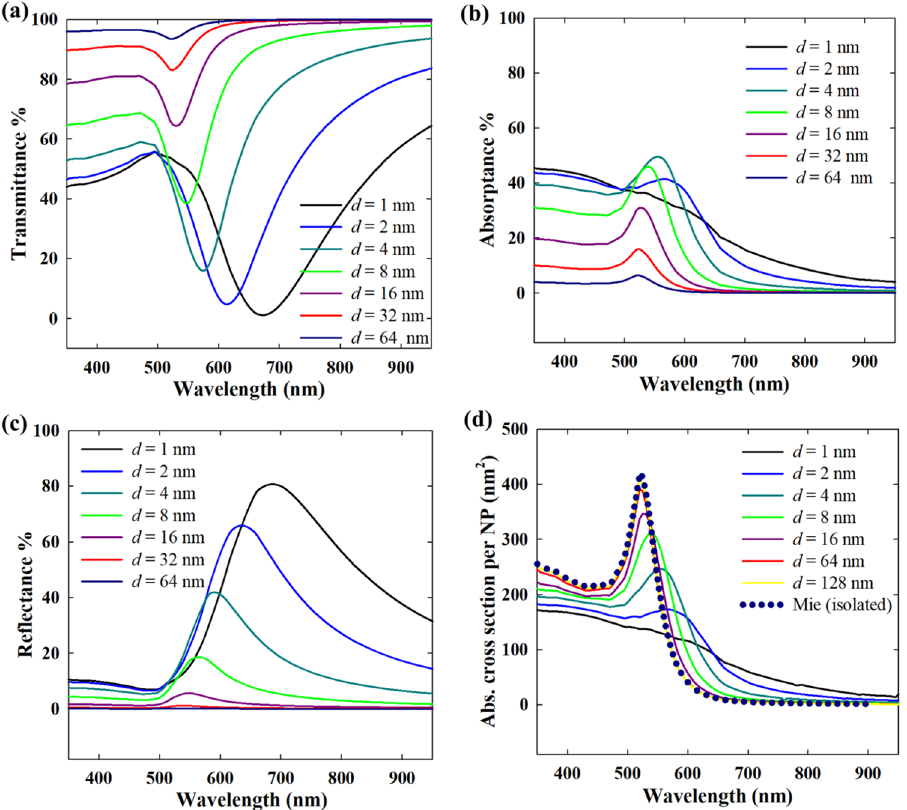
Figure 4. Effect of interparticle gap ( d ) in monolayer hexagonal close packed arrays of 20 nm Au nanoparticles in dielectric medium ( n = 1.33): ( a ) transmittance, ( b ) absorptance, ( c ) reflectance, ( d ) per particle absorption cross section. The direction of incidence of illumination is normal in all